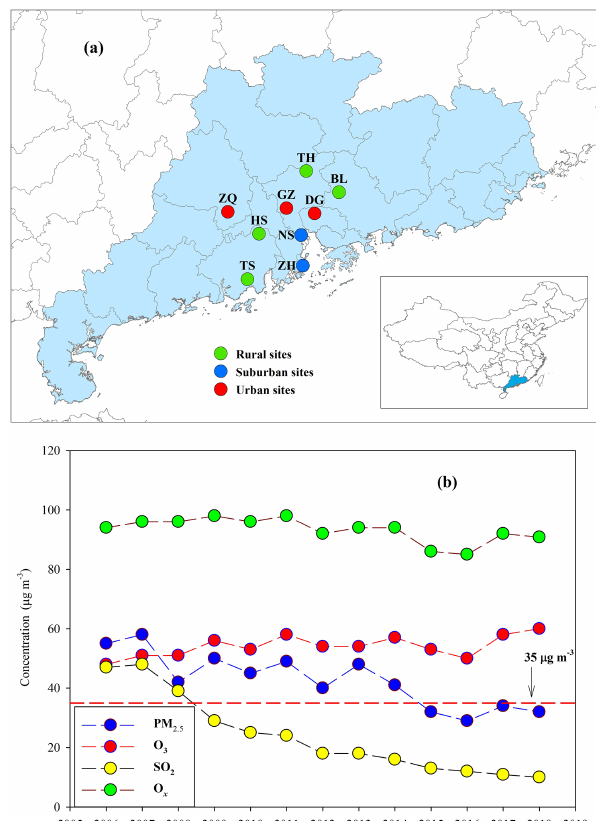
Figure 1. (a) Sampling sites in the PRD, including Zhaoqing (ZQ), Guangzhou (GZ), Dongguan (DG), Nansha (NS), Zhuhai (ZH), Tianhu (TH), Boluo (BL), Heshan (HS), and Taishan (TS), and (b) long-term trends of annual mean PM 2 . 5 , O 3 , SO 2 , and O x recorded by the Guangdong–Hong Kong–Macao regional air quality moni- toring network (http://gdee.gd.gov.cn/kqjc/, last access: 26 Novem- ber 2019) . The red dashed line indicates the NAAQS for annual mean PM 2 . 5 concentrations (35µgm − 3 )